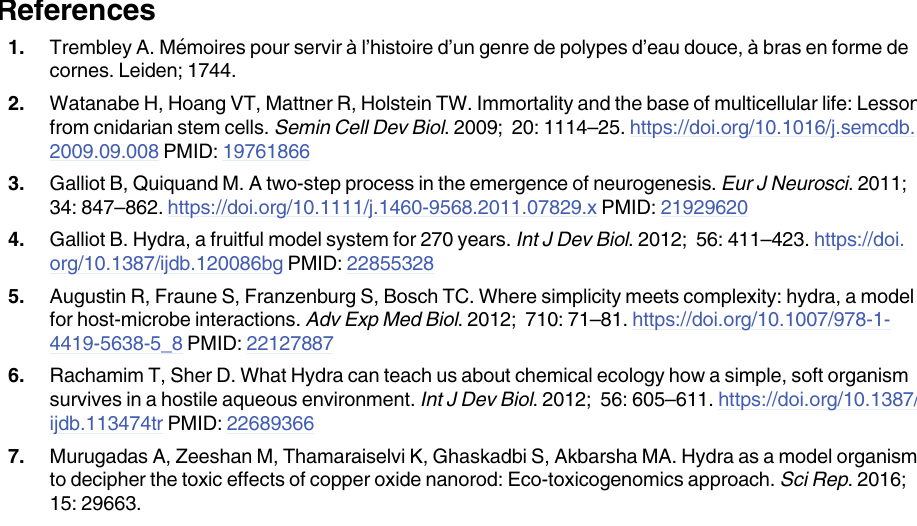
S4 Fig. Alignment of the putative Hydra c25145 protein with related gene products identi- fied in bilaterian species. S5 Fig. Alignment of the ms-AIP Hydra genomic and transcriptomic sequences and expres- sion profiles. S6 Fig. Alignment of the Hydra transcriptomic and genomic sequences corresponding to ms-DMTF1 . S7 Fig. Expression profile of the Hydra DMTF1